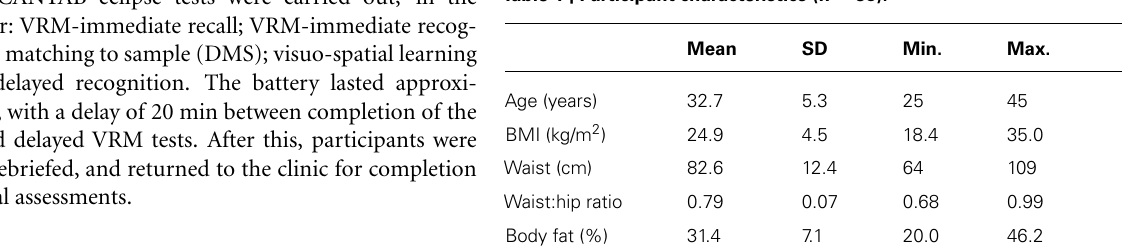
Table 1 | Participant characteristics ( n =